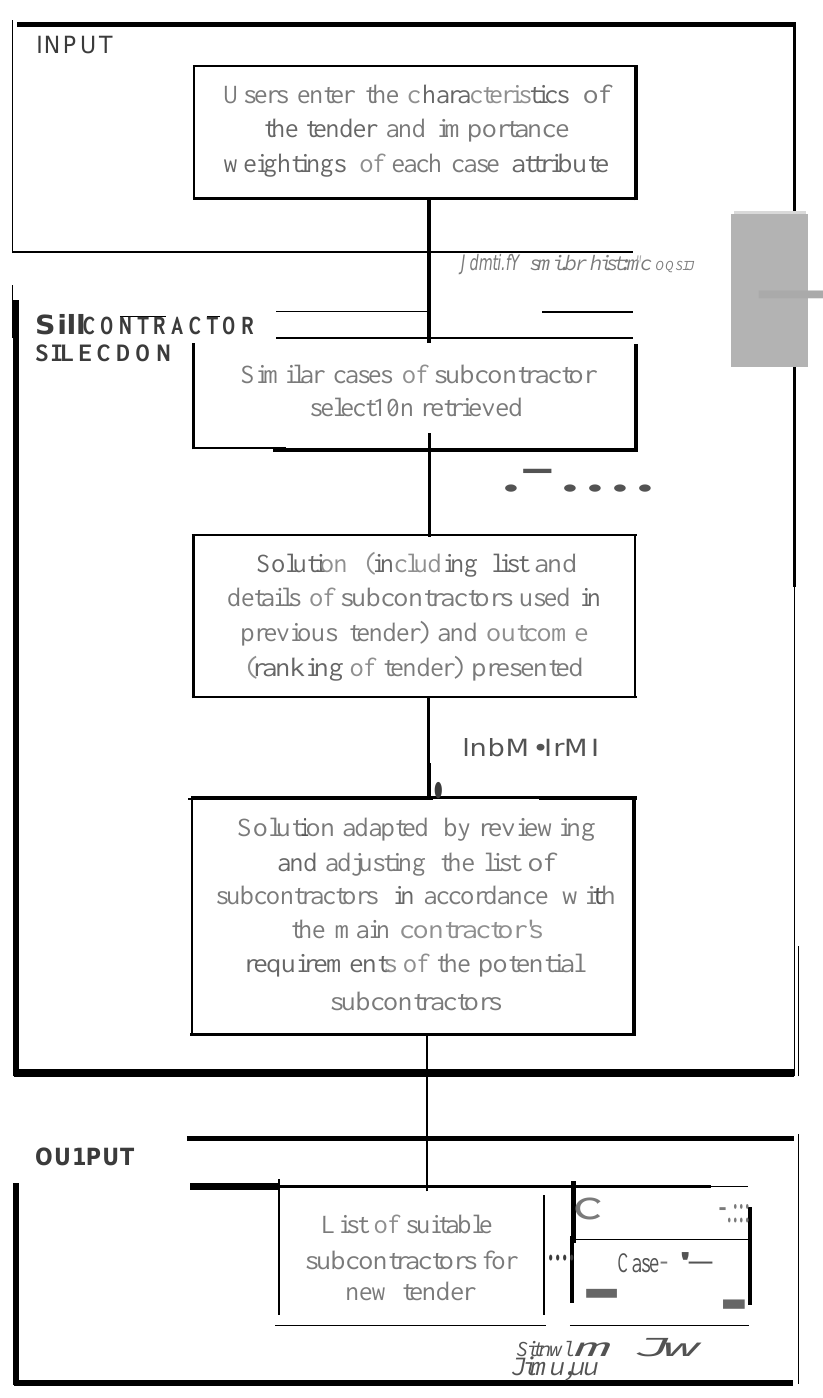
Figure 2: Conceptual framework of the case-based system for selecting